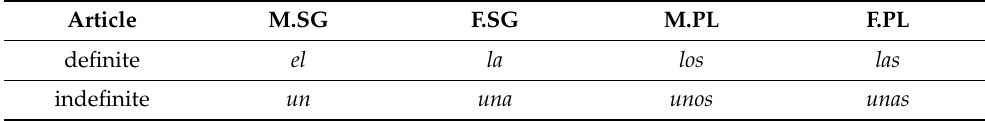
Table 2. Gender and number distribution in definite/indefinite articles in